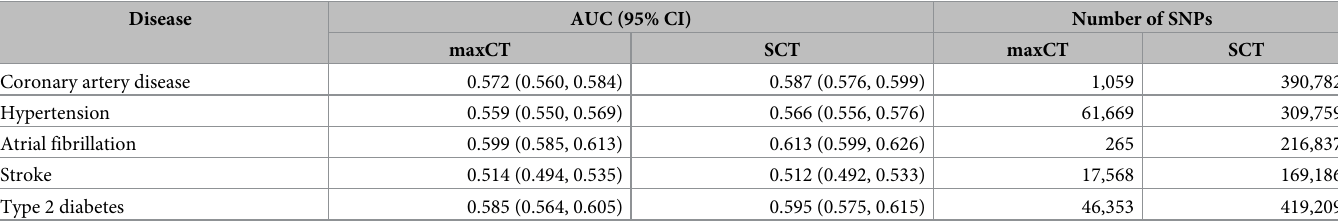
Table 4. Predictive performance of the developed PRSs and the number of identified SNPs. Disease